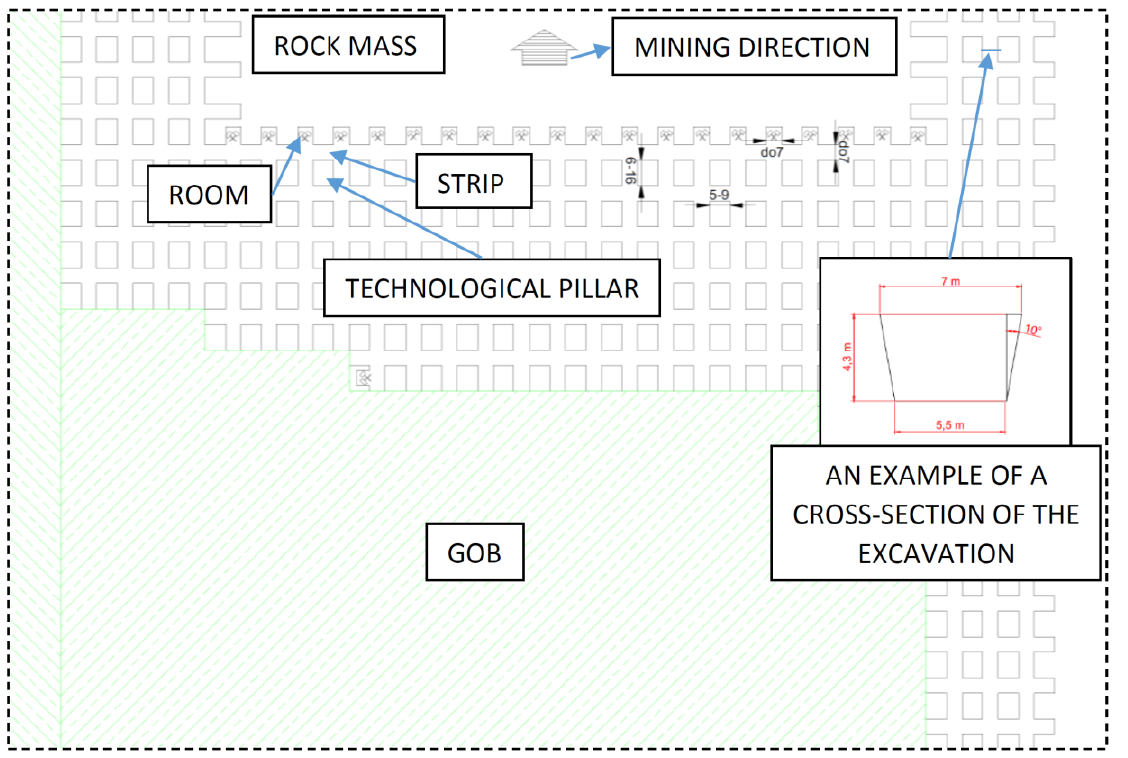
Figure 1. Room – pillar mining system with roof deflection (J-UG-PS) [24]. Figure 1. Room–pillar mining system with roof deflection (J-UG-PS) [24].